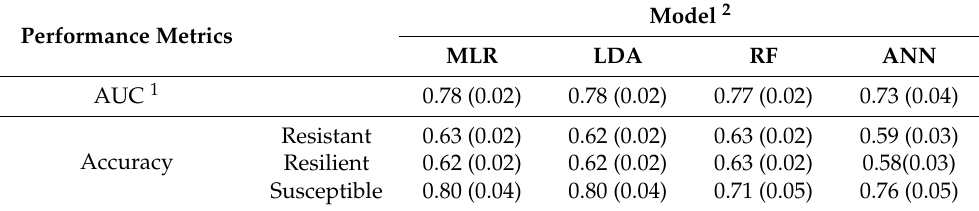
Table 1. Mean and standard deviation of the performance metrics of the multinomial logistic regres- sion (MLR), linear discriminant analysis (LDA), random forest (RF), and artificial neural network (ANN) methods using sex, age class, month of record, body weight, body condition score, and Famacha© degree as explanatory variables and response classes of the parasitic infection (resistant, resilient, and susceptible) as the response variable.